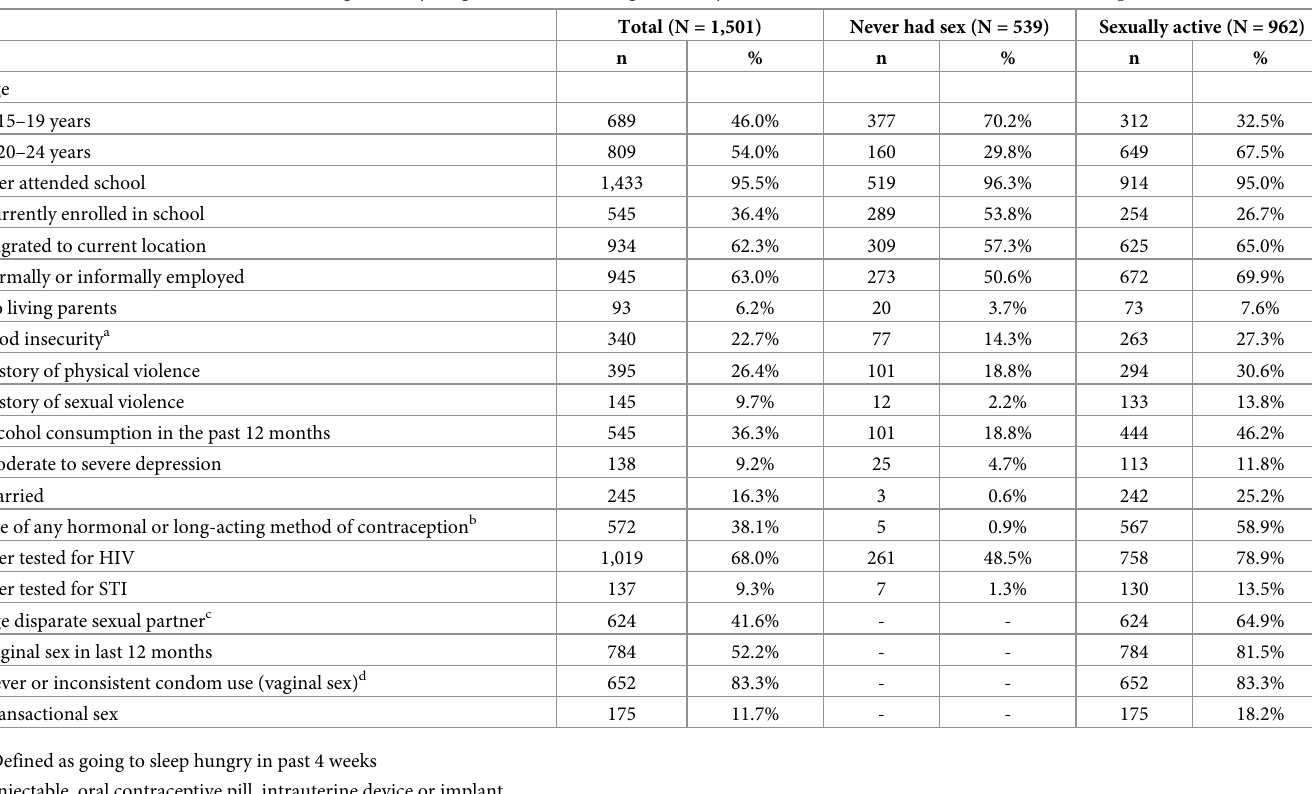
Table 1. Characteristics of 1,501 adolescent girls and young women (AGYW) aged 15–24 years in Addis Ababa and Gambella Town, Ethiopia,